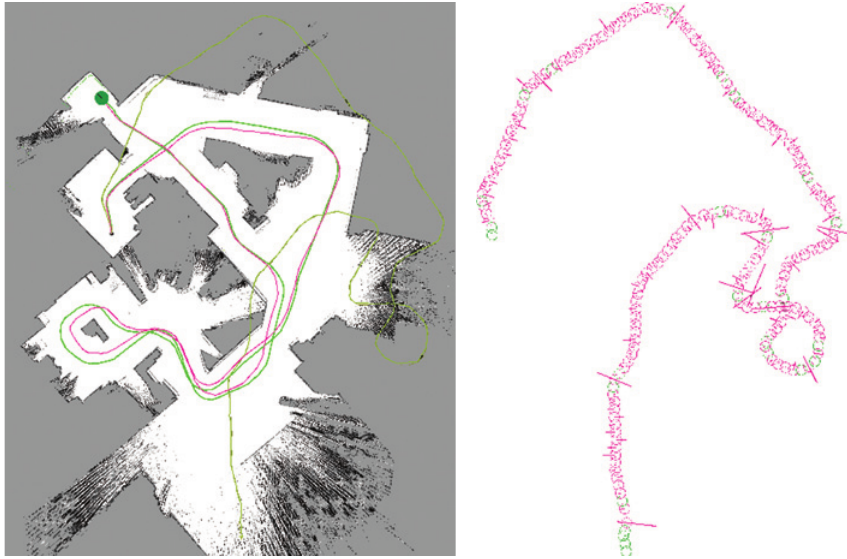
Figure 14. Large Vision-Based Path Following (≈100